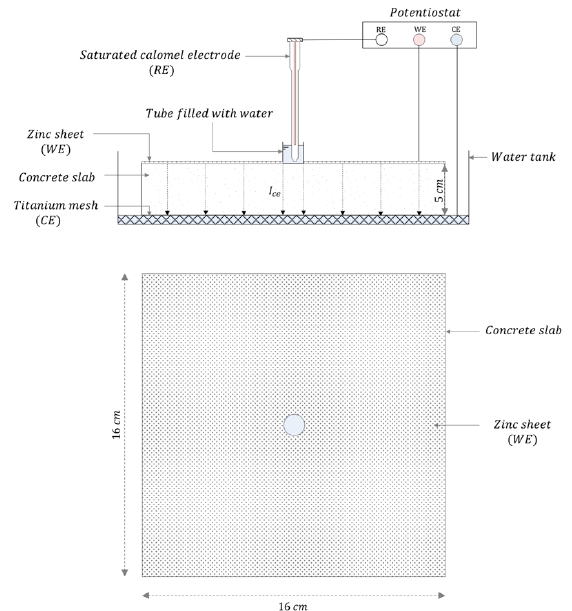
Figure 1. Description of the experimental setup.